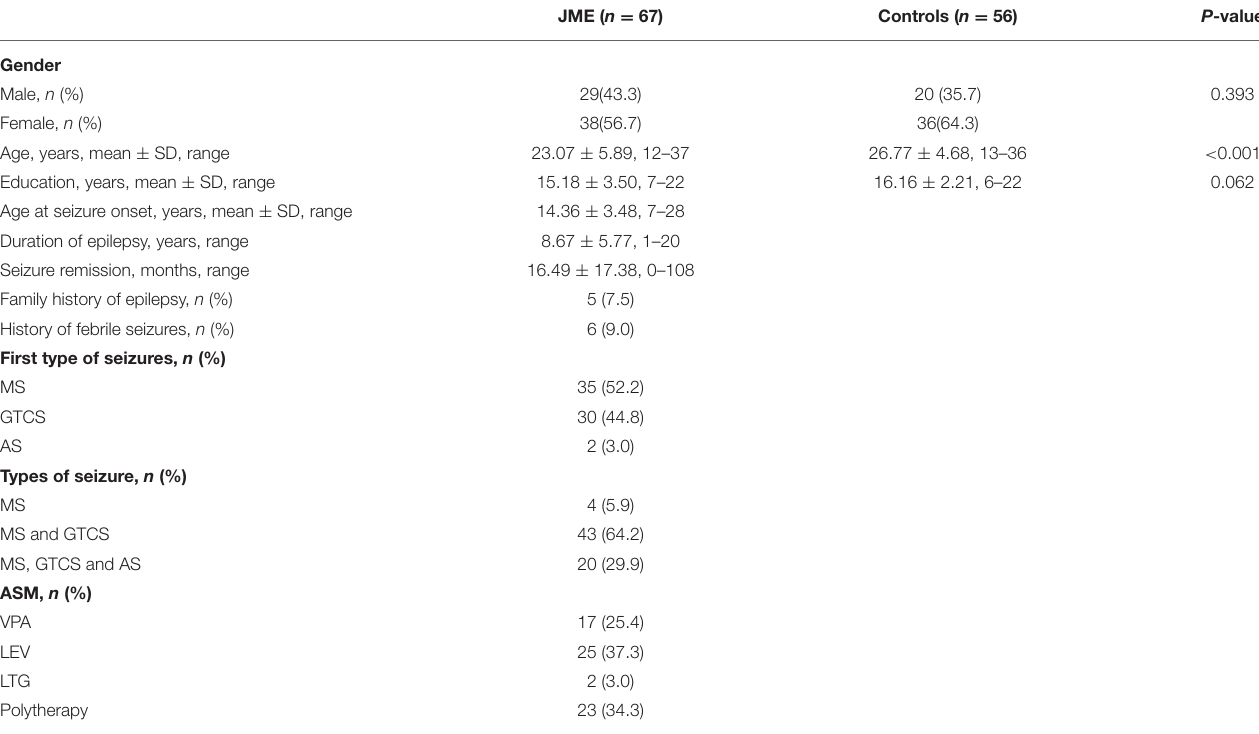
TABLE 1 | Clinical data of JME patients and healthy